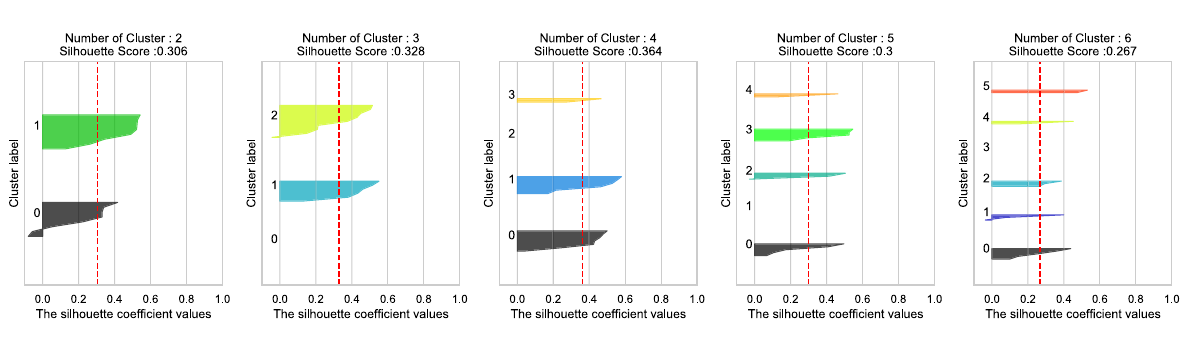
Fig. 7 Silhouette scores ( K = 2 – 6), Busan.